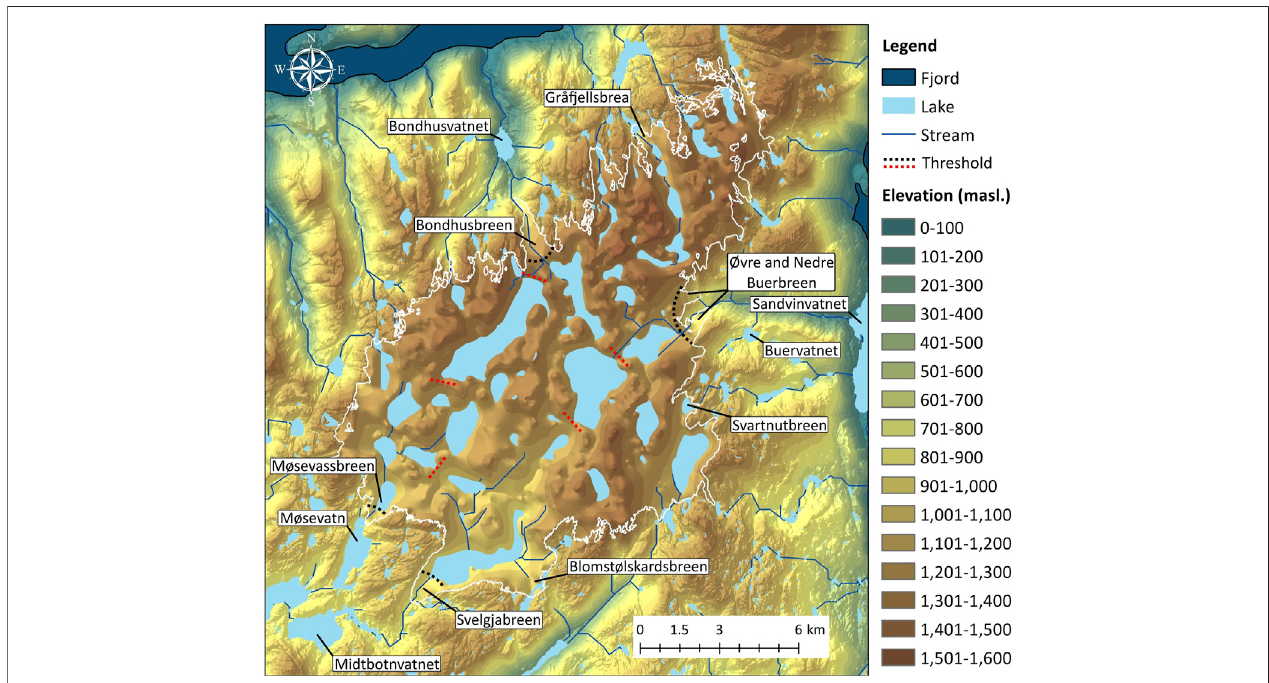
FIGURE10| ThesubglacialterrainofSørfonnawiththecurrent(2013) glacialboundarymarkedasawhiteline.Thresholdsdiscussedin Section5.4 areshownas dotted black lines. Dotted red lines show a few of the thresholds that potentially could play a role in a future GLOF event. The names on the map refer to present outlet glaciers and